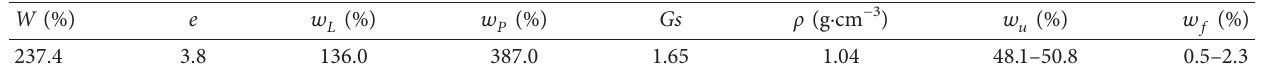
Figure 1: Sampling location, sampling process, and sample of peat soil. (a, b) Sampling site location. (c) Manual sampling. (d) Peat soil samples. Table 1: Basic physical properties of peat soil.